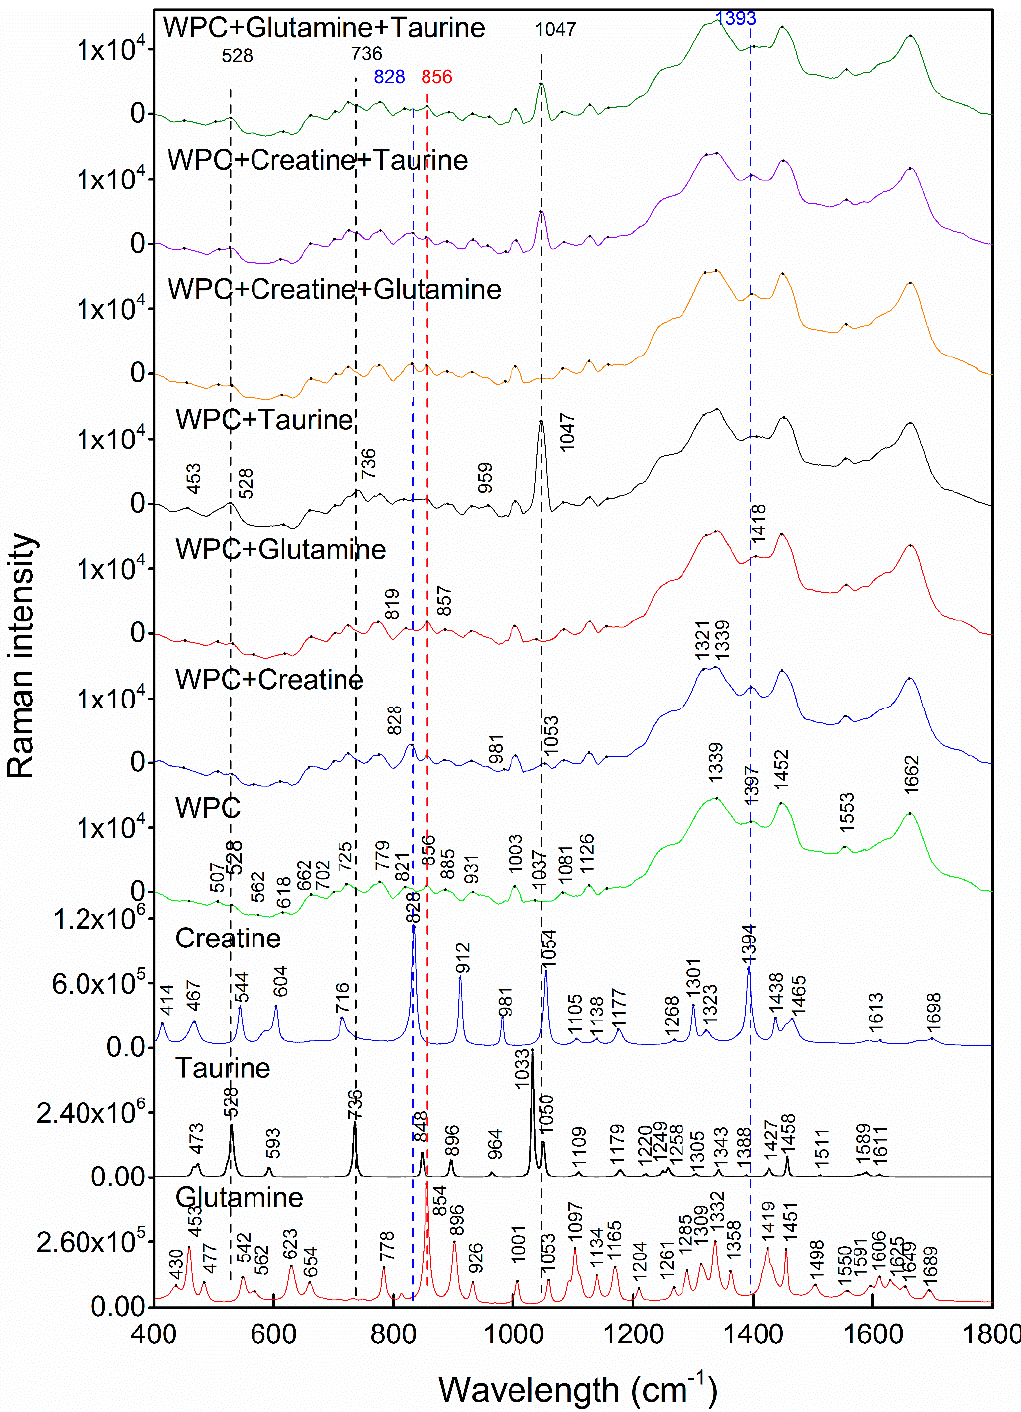
Figure 1. Pretreated Raman spectra of mixture samples with the highest adulteration levels and individual adulterants.